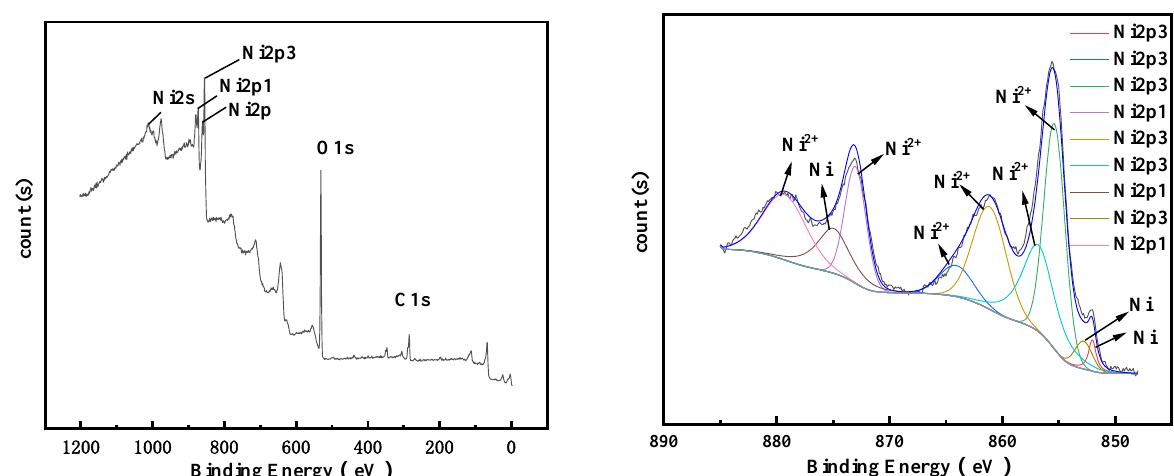
Figure 19. XPS test results of the product after 0.13 A electrolysis for 10 h.